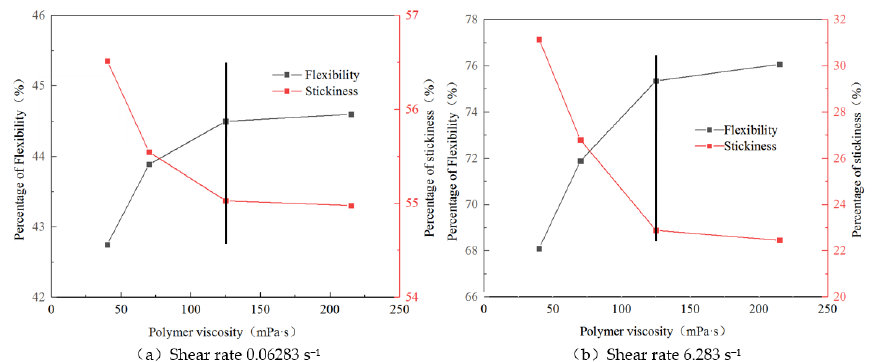
Figure 5. Proportion of viscoelasticity under different shear rates and concentrations. ( a ) Shear rate 0.06283 s − 1 . ( b ) Shear rate 6.283 s − 1 .